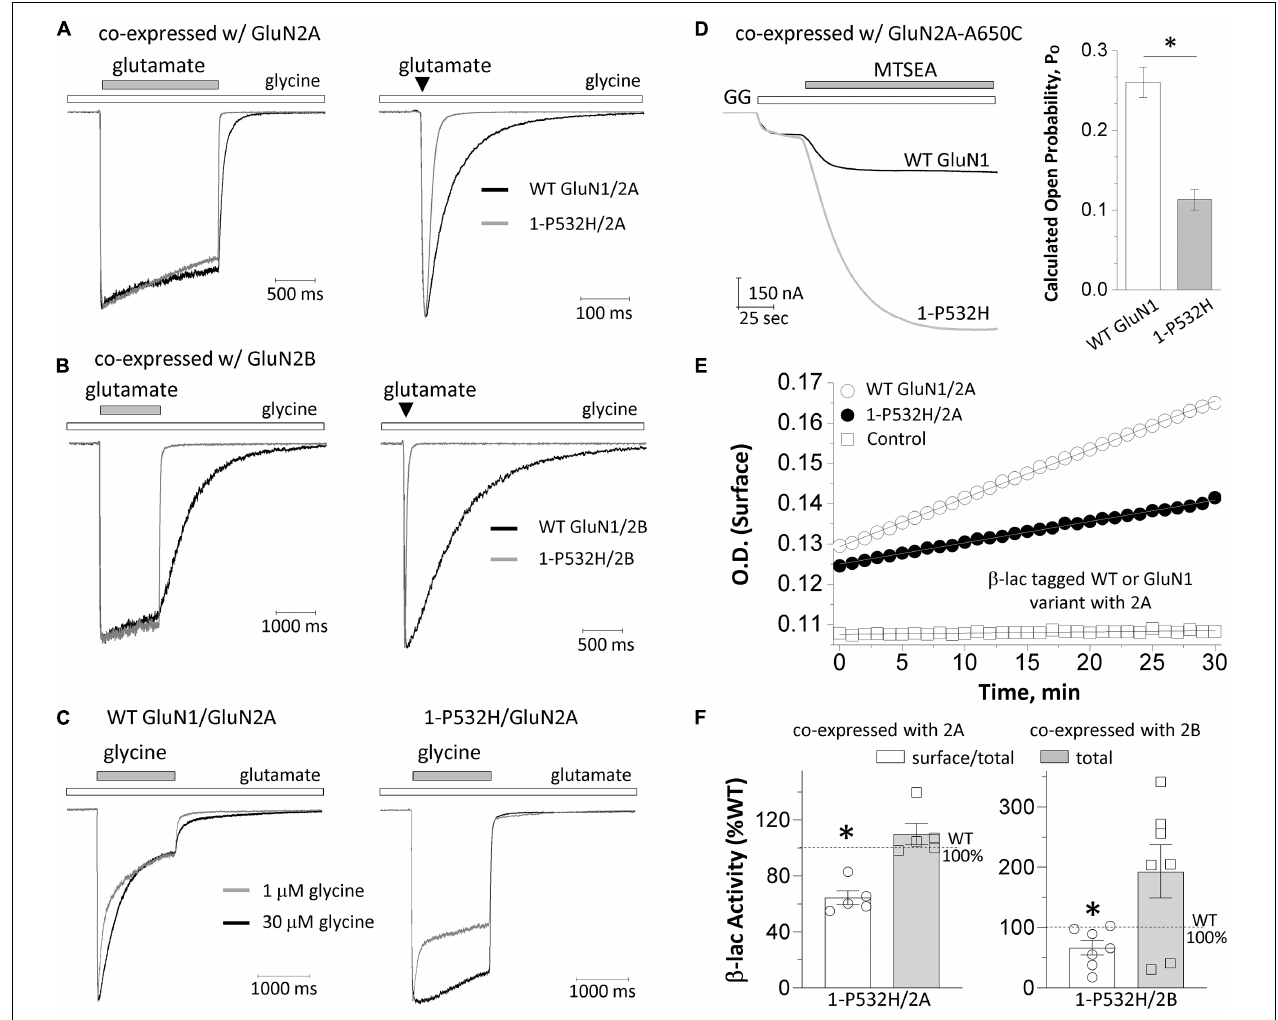
FIGURE 3 | Effects of GluN1-P532H variant on receptor biophysical properties and cell surface trafficking. (A,B) The current response was obtained from whole cell voltage clamp recordings at a holding potential of –60 mV from HEK293 cells that were transiently transfected with GluN1-P532H/GluN2A (A) or GluN1-P532H/GluN2B (B) . The current amplitude generated by a prolonged application (1.5 s; left panels ) and a brief application (5 ms; right panels ) of 1,000 µ M glutamate in the presence of 100 µ M glycine was normalized to that for wild-type receptors to compare response time course, and indicated a shortened synaptic-like response time course for variant NMDARs. (C) The current response generated from HEK cells that were transfected with WT GluN1/GluN2A ( left panel ) and GluN1-P532H/GluN2A ( right panel ) by a prolonged application (1.5 s) of two concentrations of glycine (1 µ M in gray ; 30 µ M in black ) in the presence of 1,000 µ M glutamate was normalized to compare response time course and desensitization. (D) The channel open probability was evaluated by measuring the degree of MTSEA (200 µ M; closed bar) potentiation using TEVC recordings from Xenopus oocytes expressing the WT GluN1 (black) or the variant GluN1-P532H (gray) coexpressed with GluN2A-A650C at a holding potential of –40 mV and activated by 1,000 µ M glutamate and 100 µ M of glycine (GG, open bar). The GluN1-P532H-containing receptors showed an increased potentiation compared with the WT, reflecting a reduced channel open probability (see Table 1 ). (E) Representative plots of nitrocefin absorbance (optical density, OD) as a function of time are shown for HEK293 cells expressing WT β -lac-GluN1 or β -lac-GluN1-P532H coexpressed with GluN2A. (F) The slopes of OD versus time course in minutes were averaged ( n = 5–7 independent experiments) and presented as percentages of WT for the ratio of surface/total. Data are expressed as mean ± SEM and were analyzed by unpaired Student’s t -test (* p < 0.05, compared with the corresponding WT surface/total